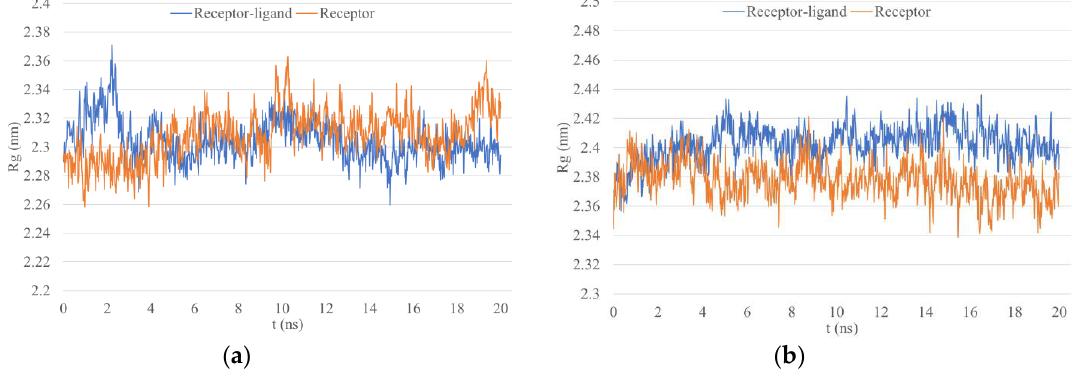
Figure 4. Residual RMSF after 20 ns simulation only for epitope residues. ( a ) WFHDIPLPW; ( b ) WAIYAALTT.